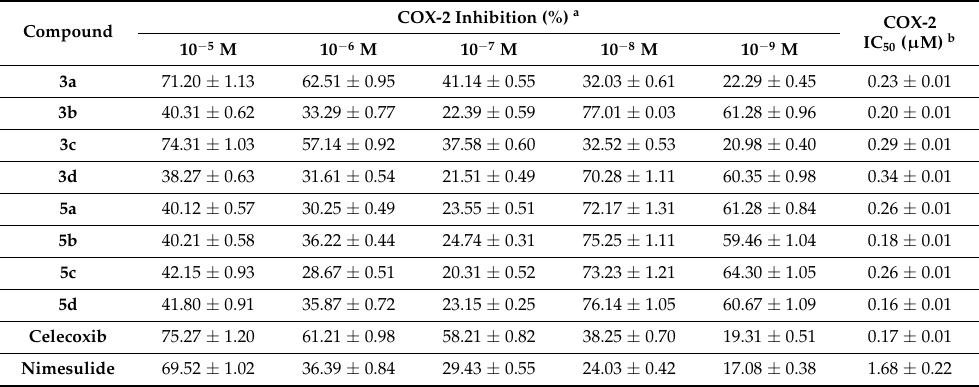
50 values of the tested com-